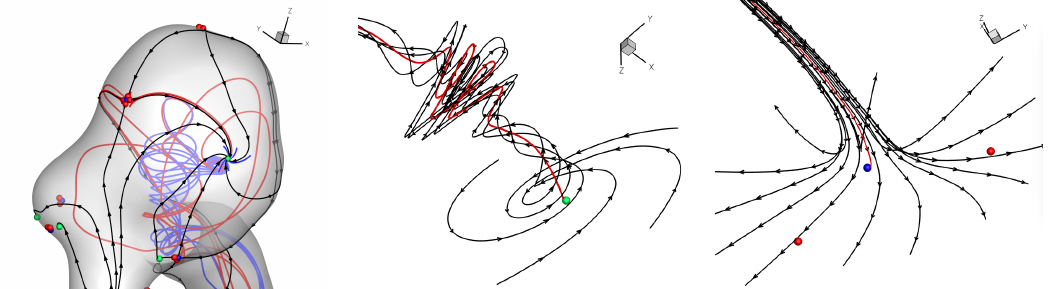
Figure 3. Detail of surface shear lines, instantaneous streamlines and wall shear stress critical points. Wall shear stress critical points are marked by coloured dots, such that green indicates a focus, hence complex conjugate pair solution, blue indicates a saddle or node, hence real solution, and red are locations a small distance along the eigenvectors (hence principal directions of dividing surface shear lines), see Equation (6). Left plot: solution for Case 1 at time = 0.181 s; velocity streamlines are coloured blue if originating near a focus WSS critical point, and red if originating near a saddle/node WSS critical point. Middle plot: detail of stable focus, showing how the flow moves in a spiral manner in the plane of the wall, gradually moving away from the wall. The red streamline indicates the spiralling core. We observe an interaction with the free-stream flow soon after, the vortex compresses before stretching again and continuing further into the aneurysm. Right plot: detail of an unstable node, showing how flow impinges on the wall and spreads out. The red streamline ends at the stagnation point. Red dots indicate direction of principal axes (the eigenvectors) on one side only of the critical